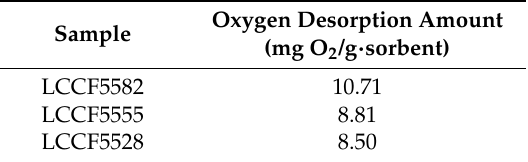
Table 3. Oxygen desorption amount of La 0.5 Ca 0.5 Co 1 − y Fe y O 3 − δ (y = 0.2, 0.5, 0.8).